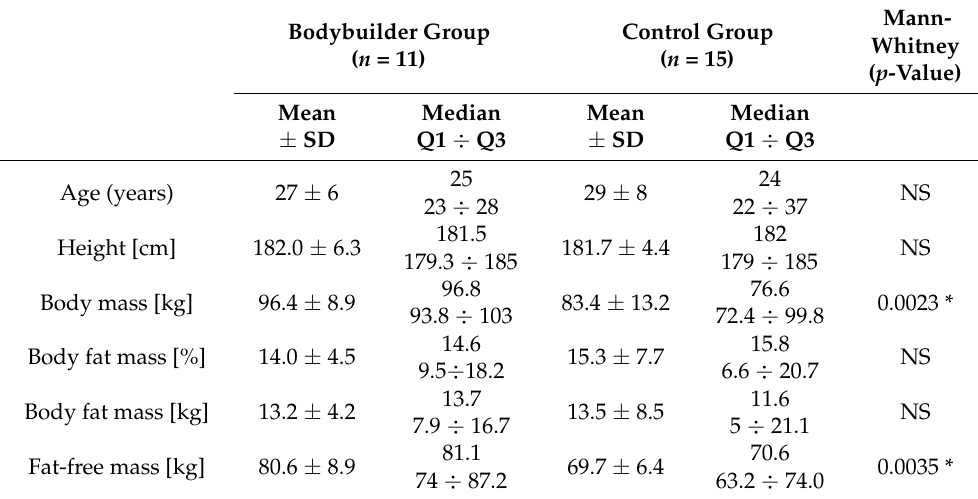
Table 4. Comparison of basic characteristics of body composition.